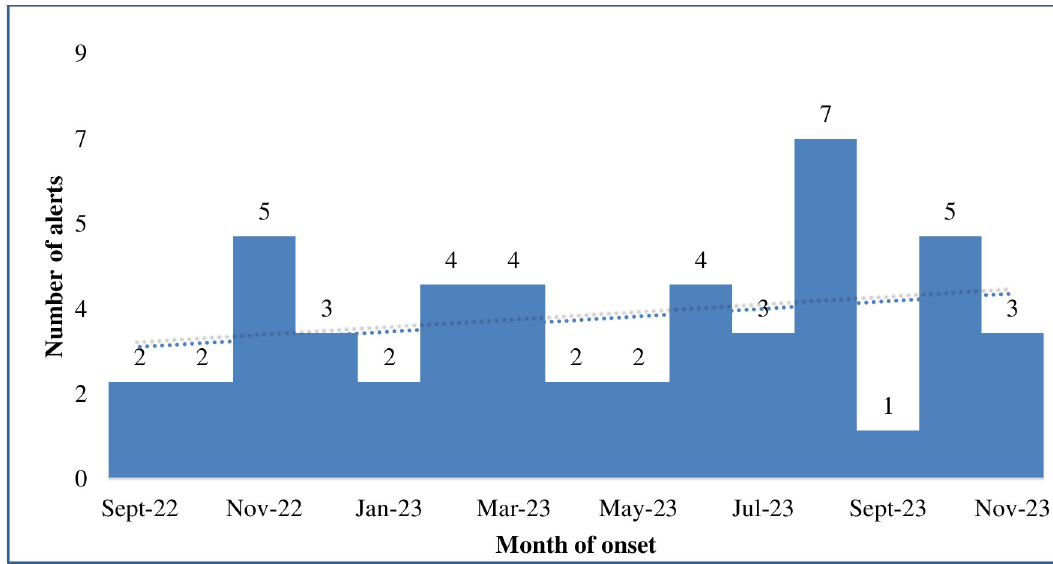
Fig 5. Distribution of EVD alerts by months in South Sudan—August 2018 to November